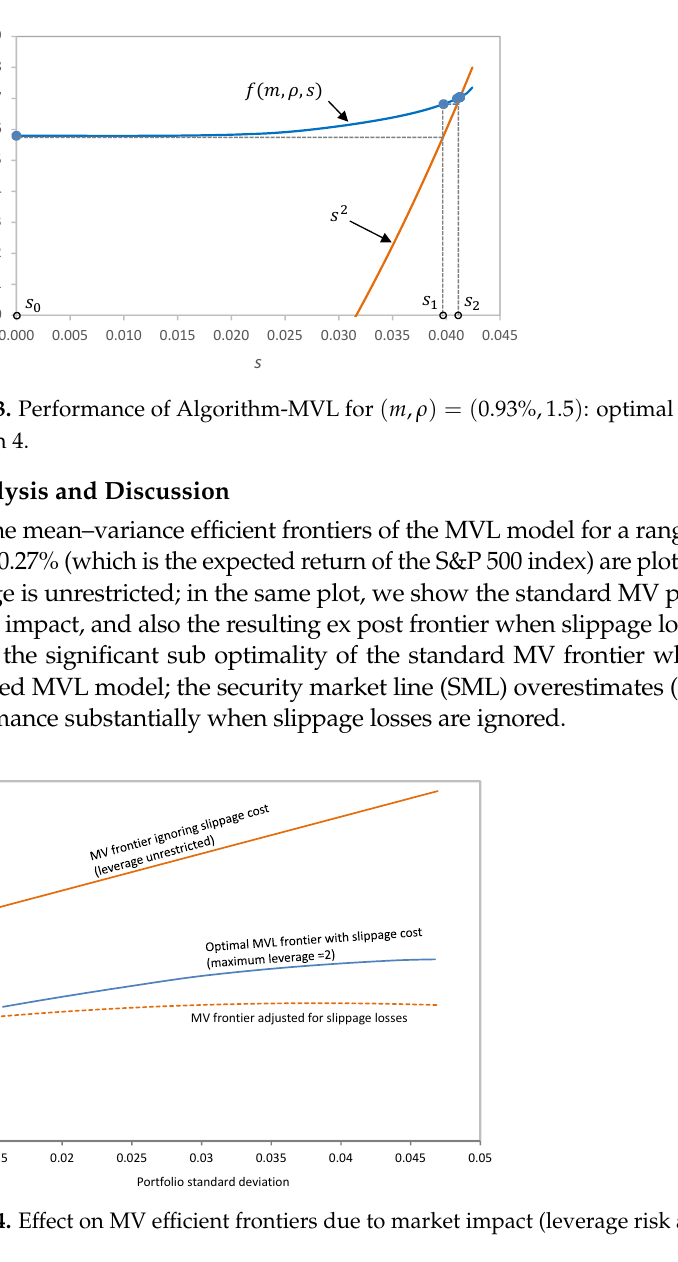
averse, say θ = Z − 1 ( 1 − 0.6 ) = − 0.2533? Using the monthly risk-free rate of